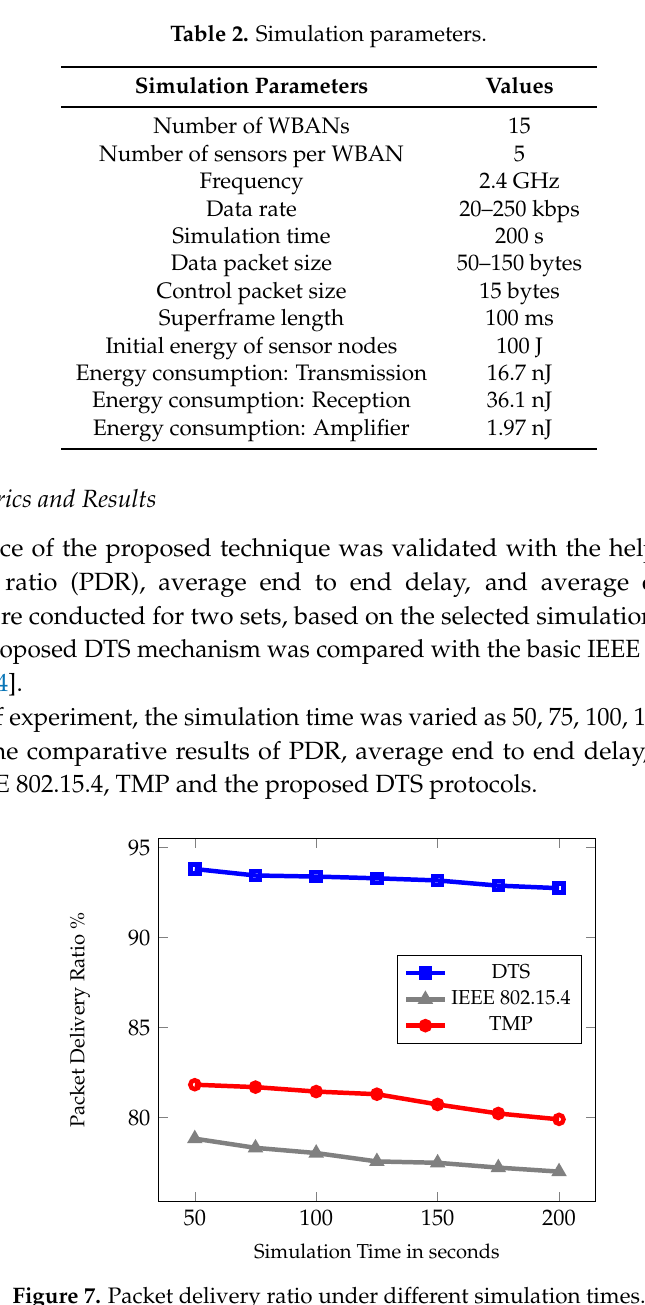
Figure 7. Packet delivery ratio under different simulation